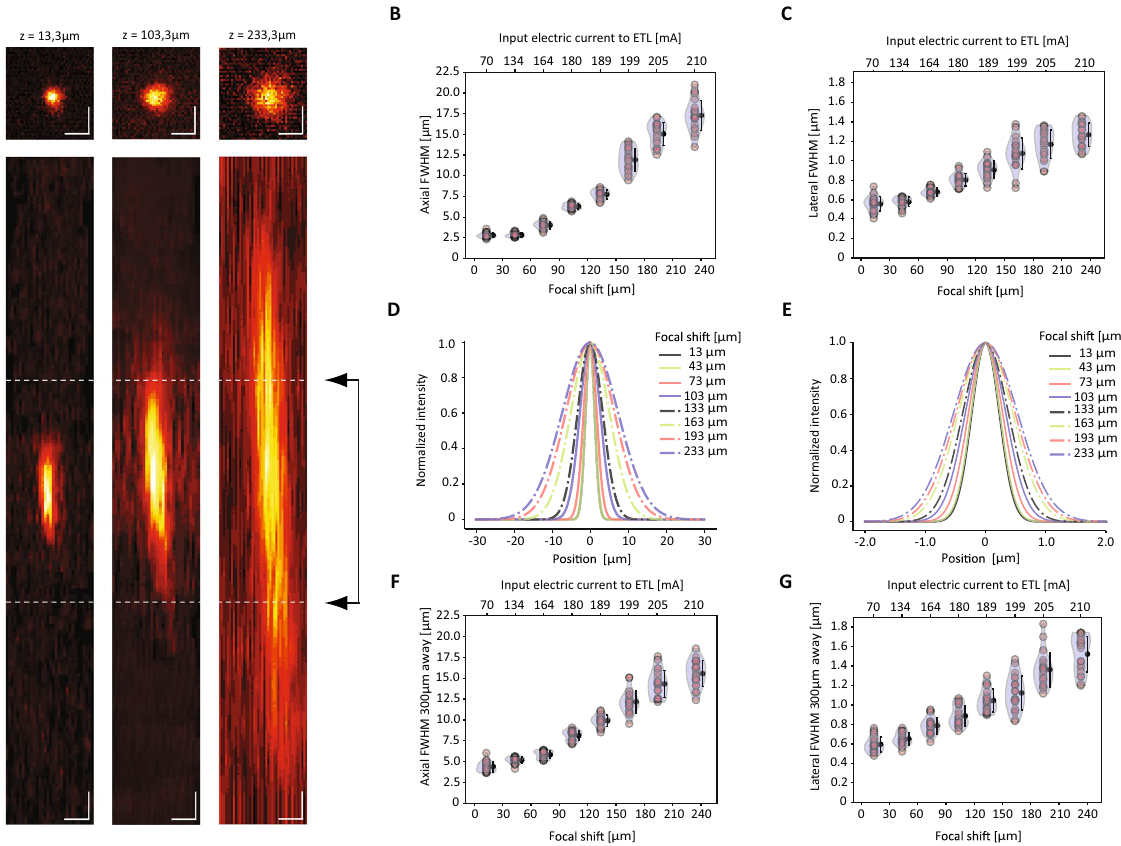
Figure 2. Optical performances of the system. ( A ) Average intensity projections (upper row with top-view XY, lower row with side view ZX) of the point spread function (PSF) measured at 920 nm on 0.2 μm fluorescent beads at three different settings of the ETL tuning range, z = 13.3 μm, z = 103.3 μm and z = 233.3 μm. Highlighted with dashed lines is the typical cell size (6 μm). Scale bar = 1 μm. ( B,C ) Axial and lateral FWHM of the PSF as function of the ETL defocus and of the corresponding ETL driving current, for beads measured within 50 μm from the center of the FOV. ( D,E ) Axial and lateral intensity profile of the PSF for beads measured within 50 μm from the center, corresponding to eight different settings of the ETL. ( F,G ) Axial and lateral FWHM of the PSF as function of the ETL defocus and of the corresponding ETL driving current, for beads measured at 300 μm from the center of the